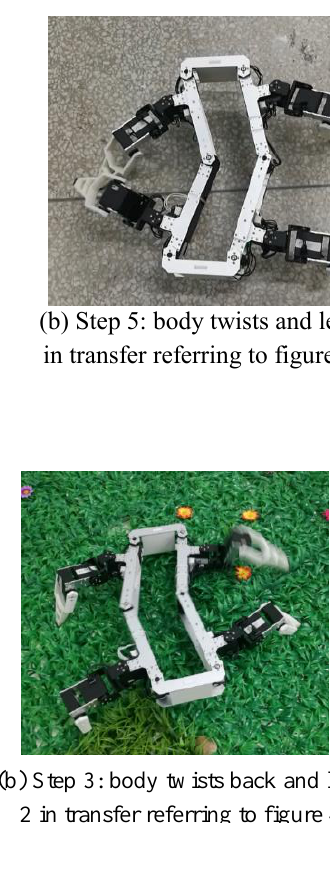
Figure 19. The MetaRobot I walking on grasses.